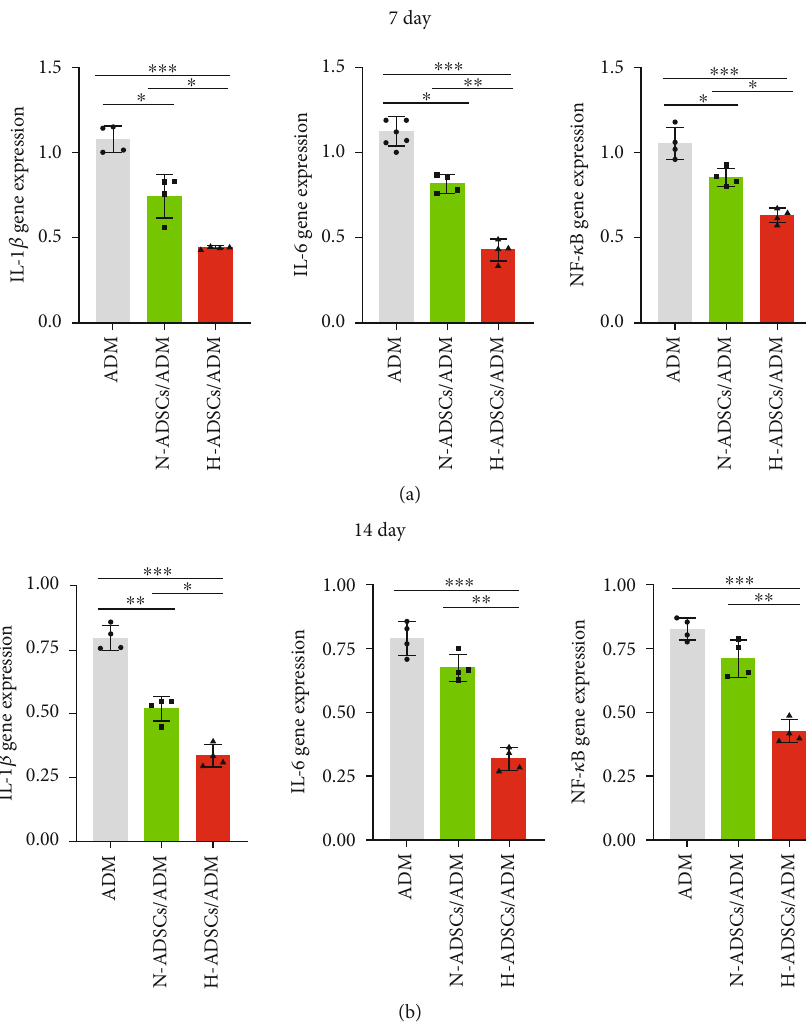
Figure 10: H-ADSCs/ADM membrane inhibiting the gene expression of proin fl ammatory cytokine in diabetic wounds. The expression of proin fl ammatory cytokines (IL-1 β , IL-6, and NF- κ B) in the wound tissues of the ADM, N-ADSCs/ADM, and H-ADSCs/ADM groups was evaluated by qRT-PCR. The gene expression levels of IL-1 β , IL-6, and NF- κ B at (a) 7 days and (b) 14 days, n = 4 per group. All data are shown as means ± standard deviation ( ∗ P < 0 : 05 , ∗∗ P < 0 : 01 , and ∗∗∗ P < 0 : 001